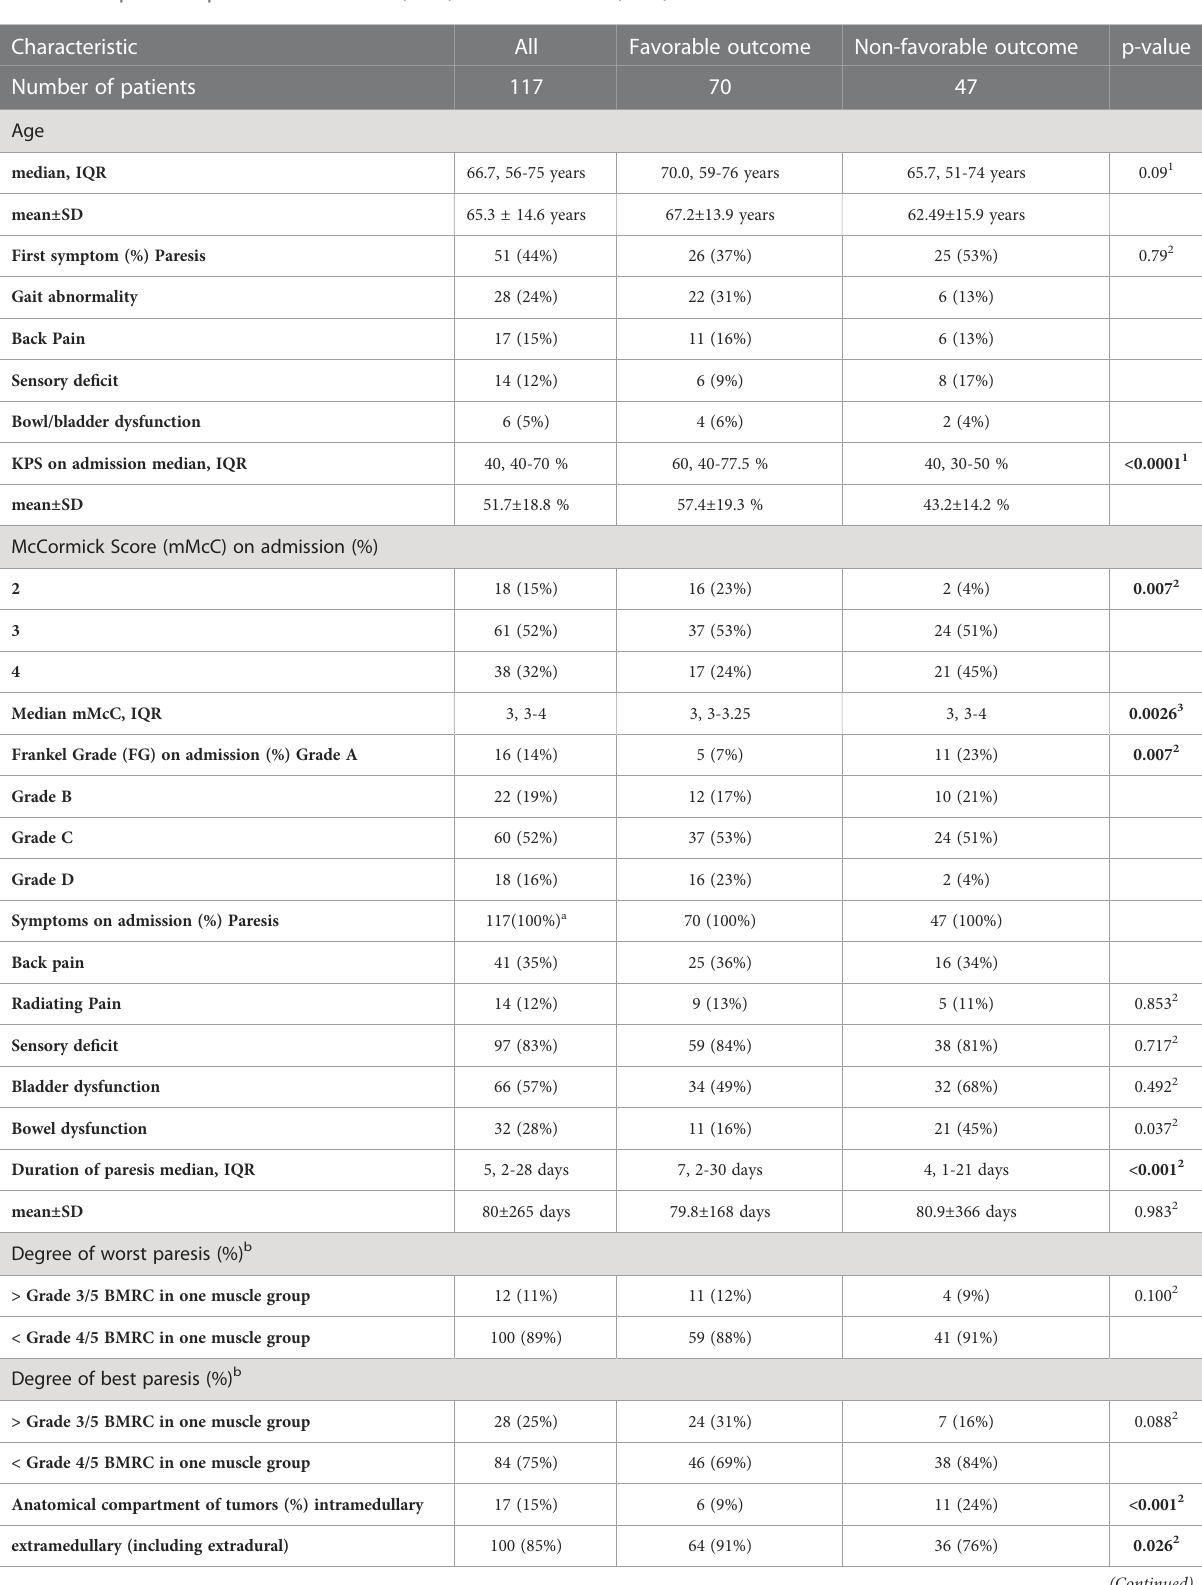
TABLE 2 Comparison of patients with favorable (n=70) and non-favorable (n=47)